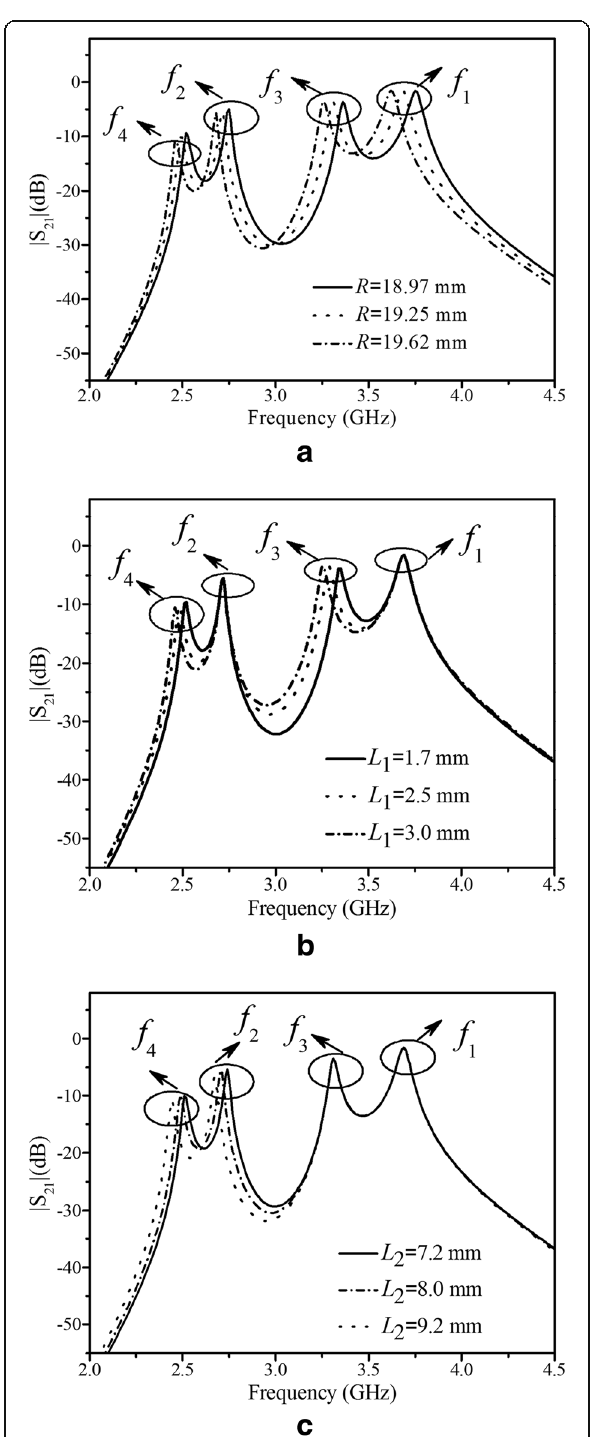
Fig. 3 The effects of structural parameters on the resonant frequency.